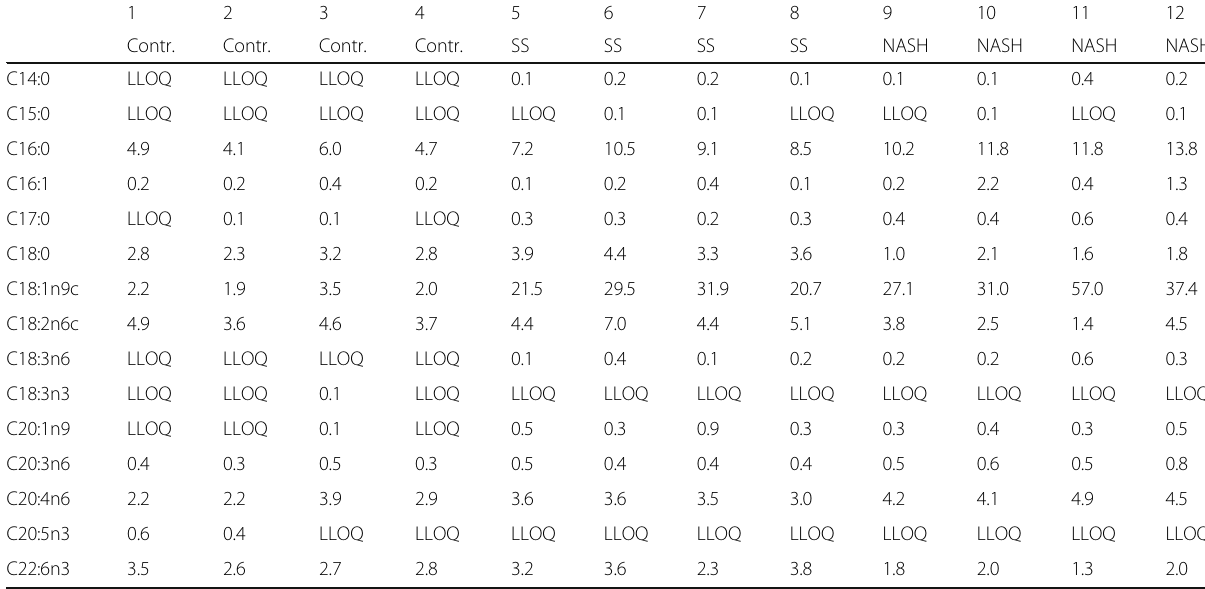
Table 3 Concentration of free fatty acids in mouse liver